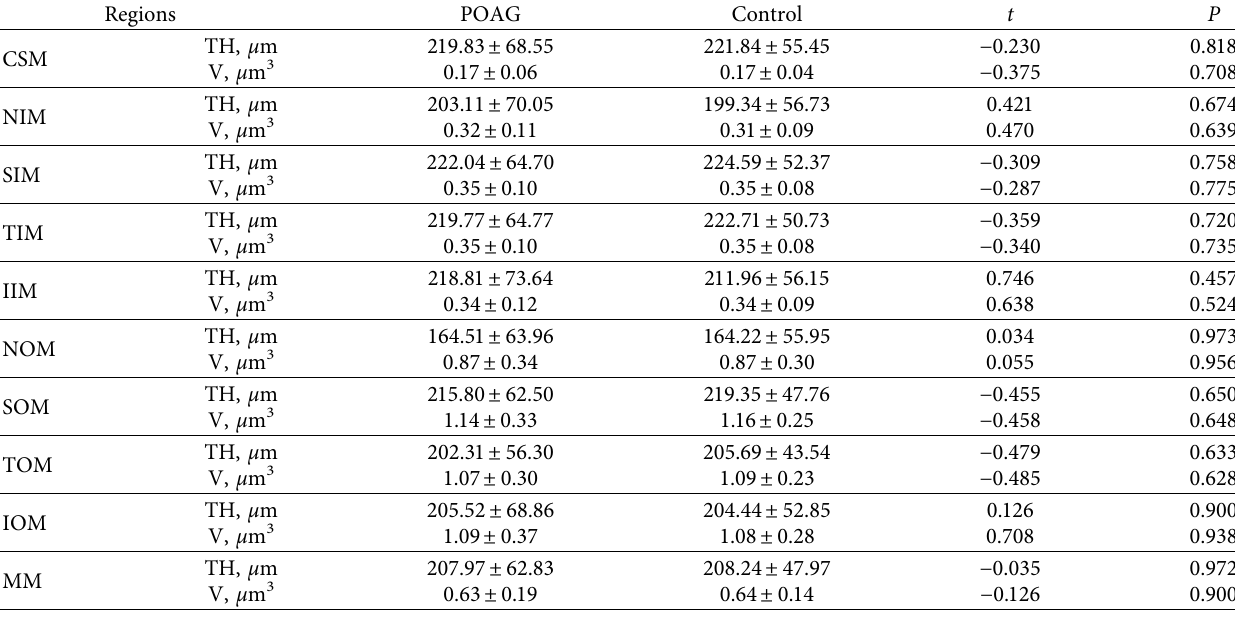
Table 2: Comparisons of macular choroidal thickness by EDI-OCT in the two groups. Regions POAG